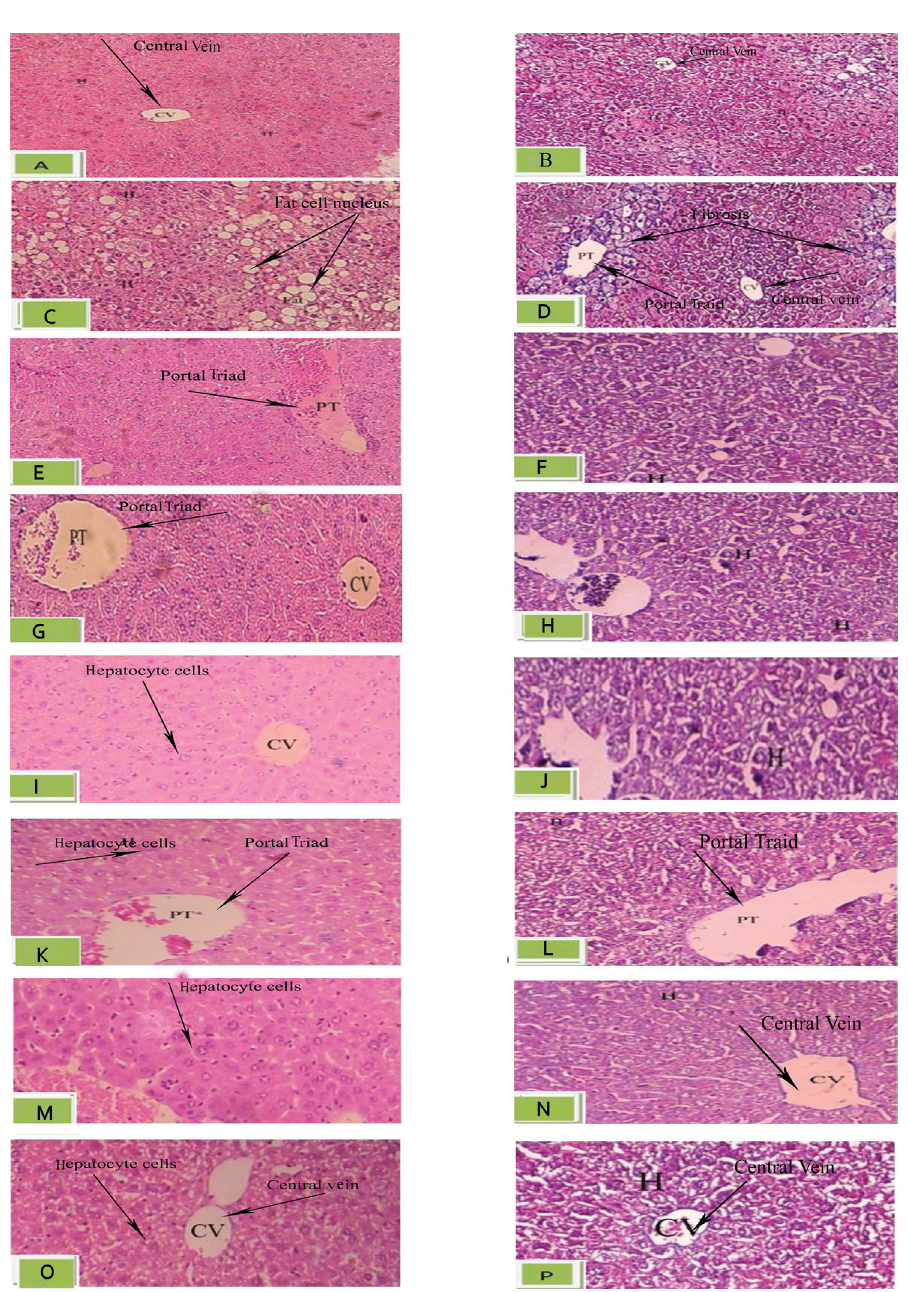
FIGURE 2 - Histopathological effects of citral on liver tissue in HF-fed mice (magnification:100). Liver tissue sections assessed by Hematoxyline & Eosin (H&E- A,C,E,G,I,K,M) and Masson’s trichorome (MT- B,D,F,H,J,L,N) perivenular fibrosis was observed in Masson’s trichrome , arrows in fig 2 D show the parts of the liver tissue that have been altered to blue color due to fibrosis. Fatty change in hepatocytes (HF) group was observed with Hematoxyline & Eosine, in Fig 2 C. The arrows show the fat cells in liver tissue. In other images of Hematoxyline & Eosine staining arrows show three different parts of liver tissue , which include central vein (CV), portal triad (PT) and hepatocyte cells (H). A: Hematoxyline & Eosin for control group; B: Masson’s trichorome for control group; C: Hematoxyline & Eosin for HF group; D: Masson’s trichorome for HF group; E: Hematoxyline & Eosin for Sh group; F: Masson’s trichorome for Sh group; G: Hematoxyline & Eosin for C+ (silymarin) group; H: Masson’s trichorome for C+ (silymarin) group; I: Hematoxyline & Eosin for EC1 ( citral 5 mg/kg) group; J: Masson’s trichorome for EC1 (citral 5 mg/kg) group; K: Hematoxyline & Eosin for EC2 (citral 10 mg/kg) group; L: Masson’s trichorome for EC2(citral 10 mg/kg) group; M: Hematoxyline & Eosin for EC3(citral 20 mg/kg) group; N: Masson’s trichorome for EC3(citral 20 mg/kg) group; O: Hematoxyline & Eosin for PC (protective) group; P: Masson’s trichorome for PC (protective) group. Abbreviation: CV(central vein), PT(portal triad) and H (hepatocyte